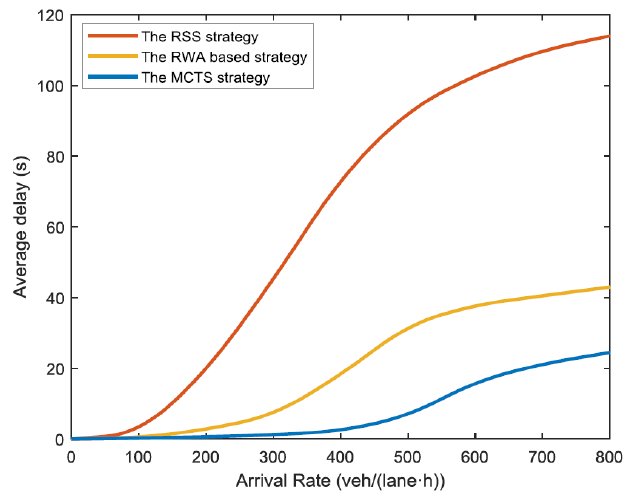
Figure 4. Accident dynamics on IM systems [31].